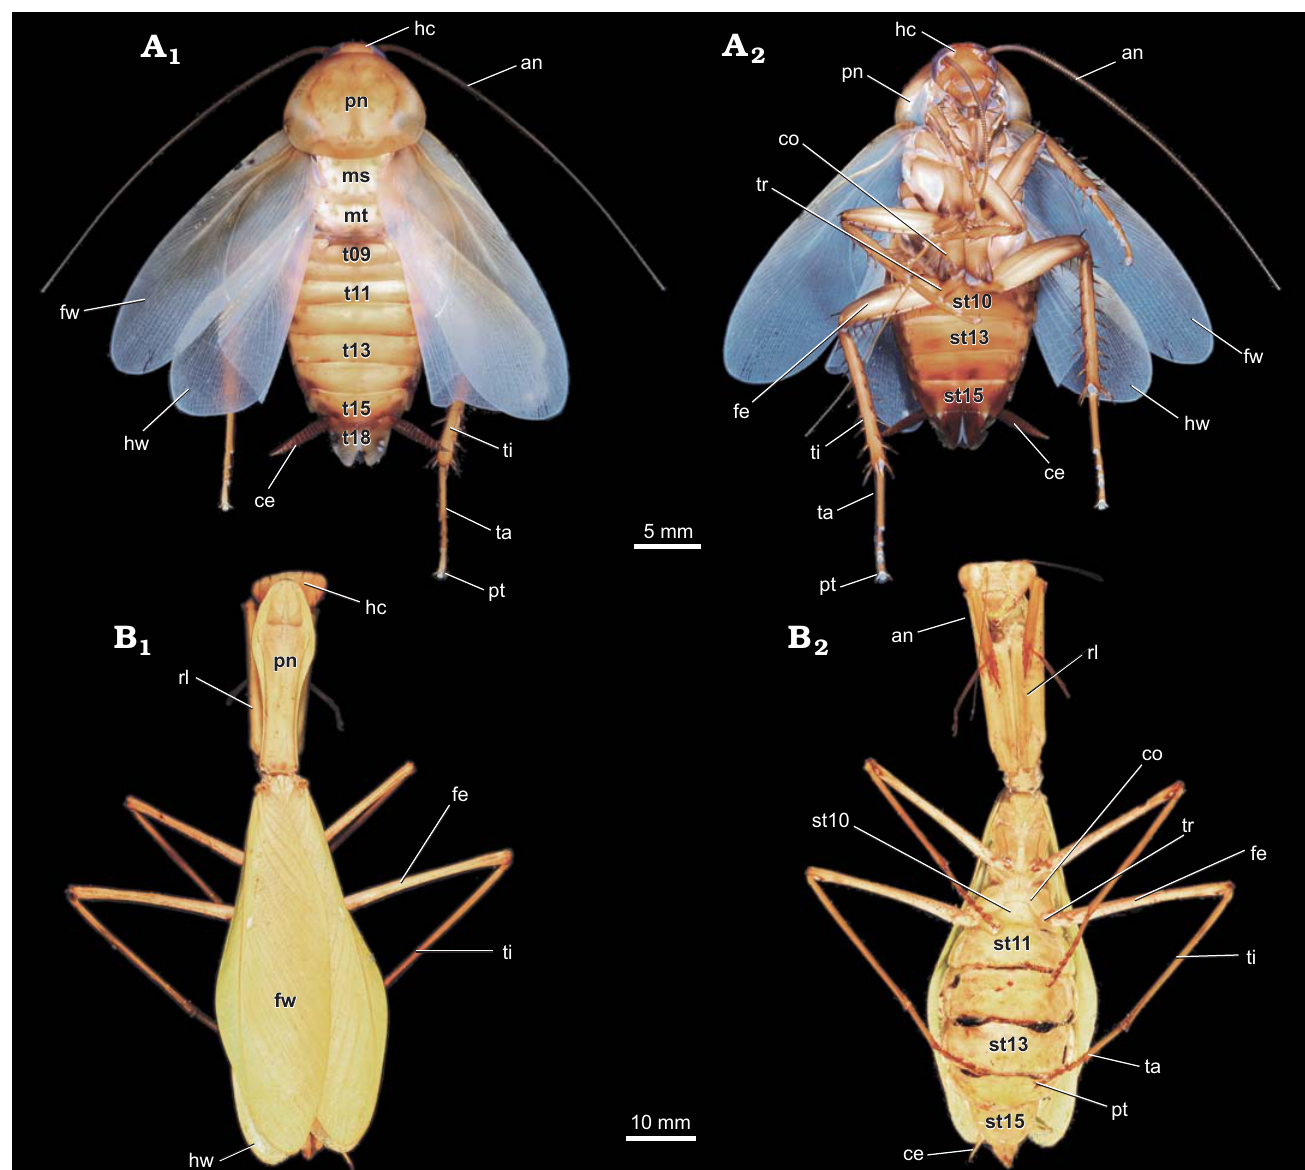
Fig. 2. General external morphology of extant Dictyoptera. A . Female of American cockroach Periplaneta americana (Linnaeus, 1758), in dorsal (A 1 ) and ventral (A 2 ) views. B . Female of giant Asian mantis Hierodula cf. grandis (Burmeister, 1838), in dorsal (B 1 ) and ventral (B 2 ) views. Abbreviations: an, antenna; ce, cercus; co, coxa of metathoracic leg; fe, femur of metathoracic leg; fw, forewing; hc, head capsule; hw, hindwing; ms, mesonotum; mt, metanotum; pn, pronotum; pt, pretarsus of metathoracic leg; rl, raptorial leg (prothoracic leg); st10–15, sternite of post-ocular segment 10–15 (abdomi- nal sternite 2–7); t9–18, tergite of the post-ocular segment 9–18 (abdominal segment 1–10); ta, tarsus of metathoracic leg; ti, tibia of metathoracic leg; tr, trochanter of metathoracic